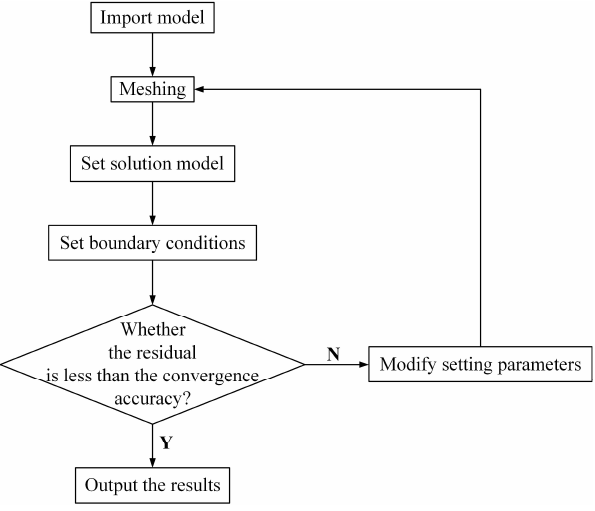
Figure 3. Simulation process.